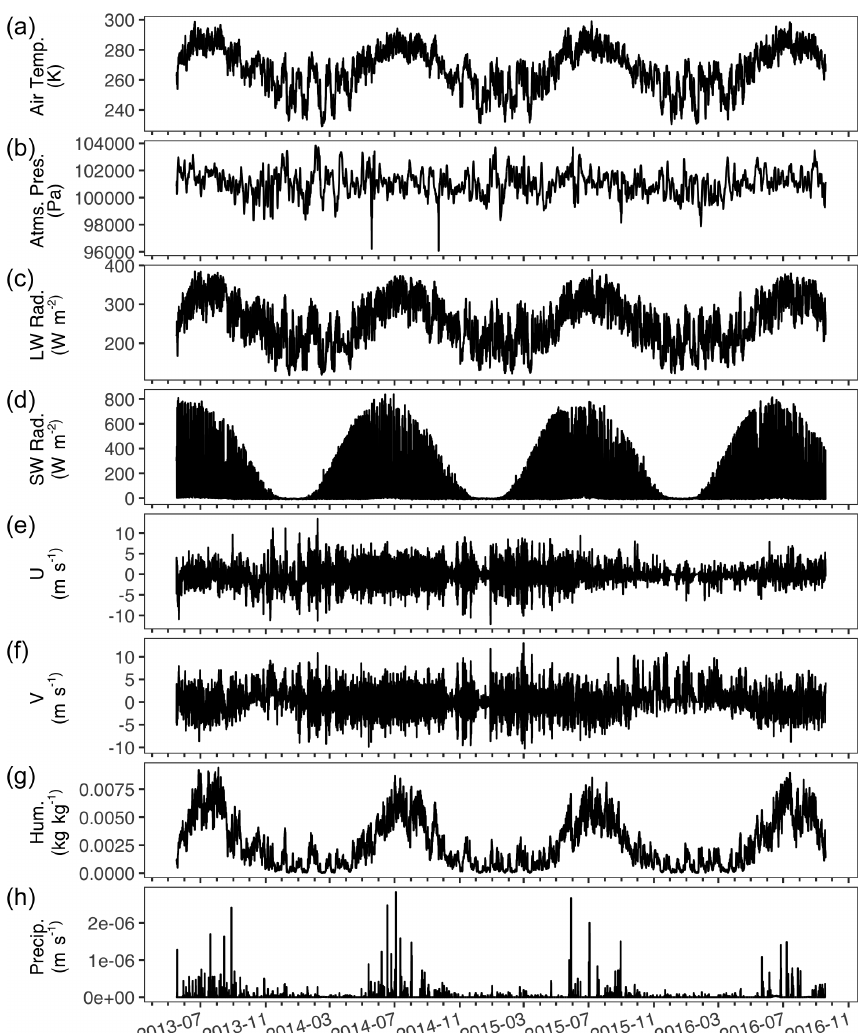
Figure A3. Toolik hourly meteorological data used in simulations. Air temperature (K) (a) , atmospheric pressure (Pa) (b) , longwave radiation (Wm 2 ) (c) , shortwave radiation (Wm 2 ) (d) , two-component wind speed (ms − 1 ) (e, f) , humidity (kgkg − 1 ) (g) , and precipitation (ms − 1 ).